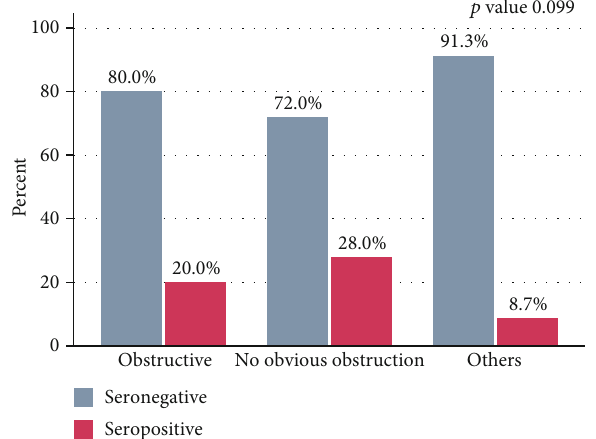
Figure 3: Cranial ultrasound patterns in seropositive and seronegative infants with hydrocephalus.